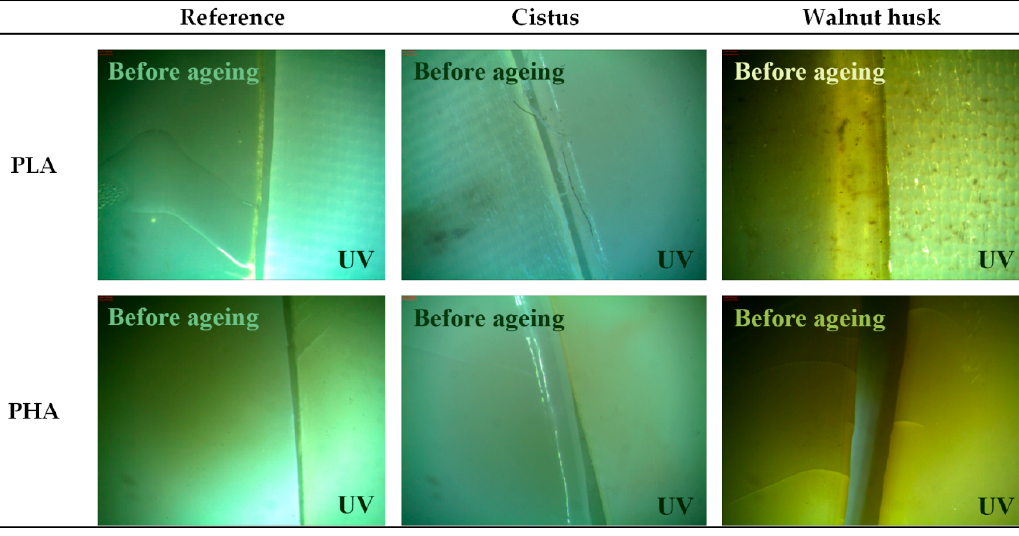
Figure 6. Visualization of the color change of PLA and PHA samples before and after UV aging. Photographs taken with an optical microscope at 43× magnification.